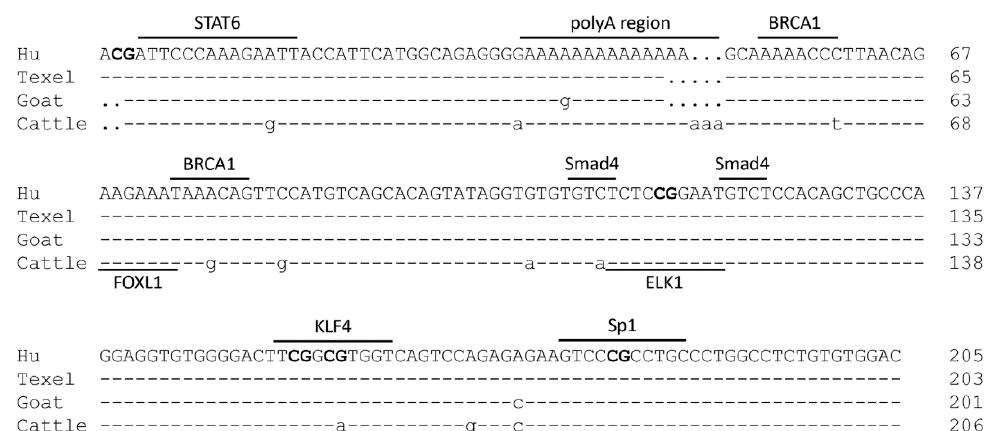
Figure 3. Sequence and putative regulatory elements of the PII core promoter region of the ovine BMPR1B gene. Underline indicates potential binding sites for transcription factors and polyA region. Bold letters represent CG site. Dot represents base deletion.